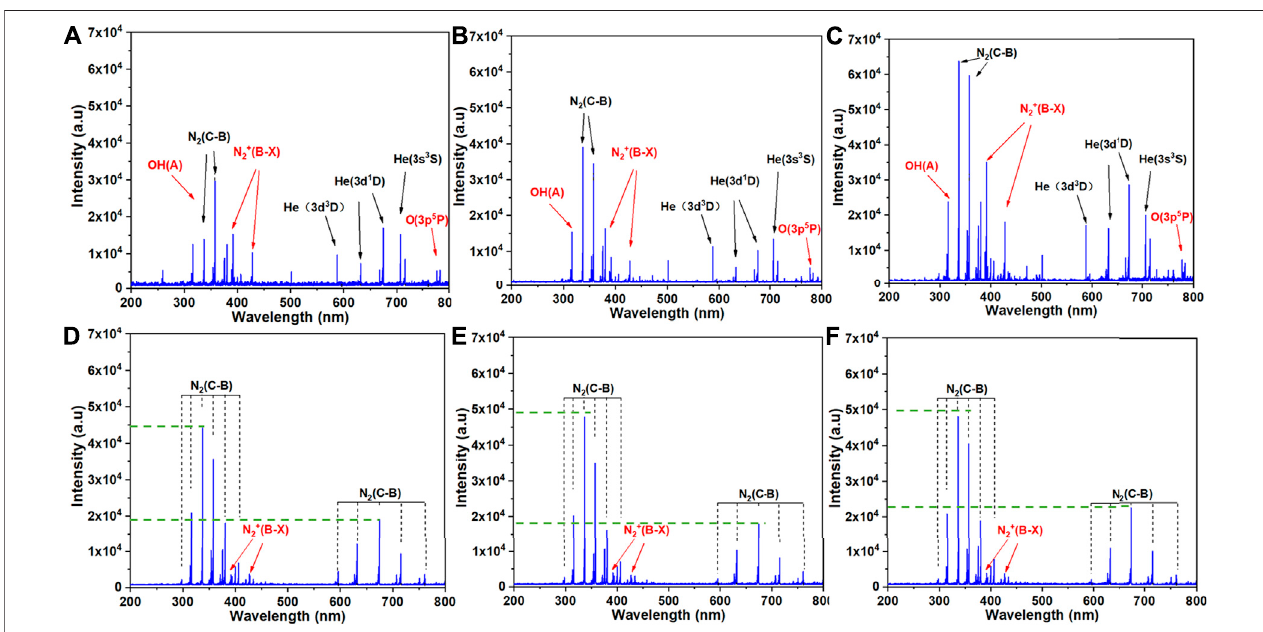
FIGURE5| Emission spectraofthetwoplasmadischarge devicesinthepresence ofthethreetypes ofsolution: (A) J-P, (B) J-N, (C) J-M, (D) S-P, (E) S-N and (F) S-M. The six treatment groups are described in Experimental setup and methods.